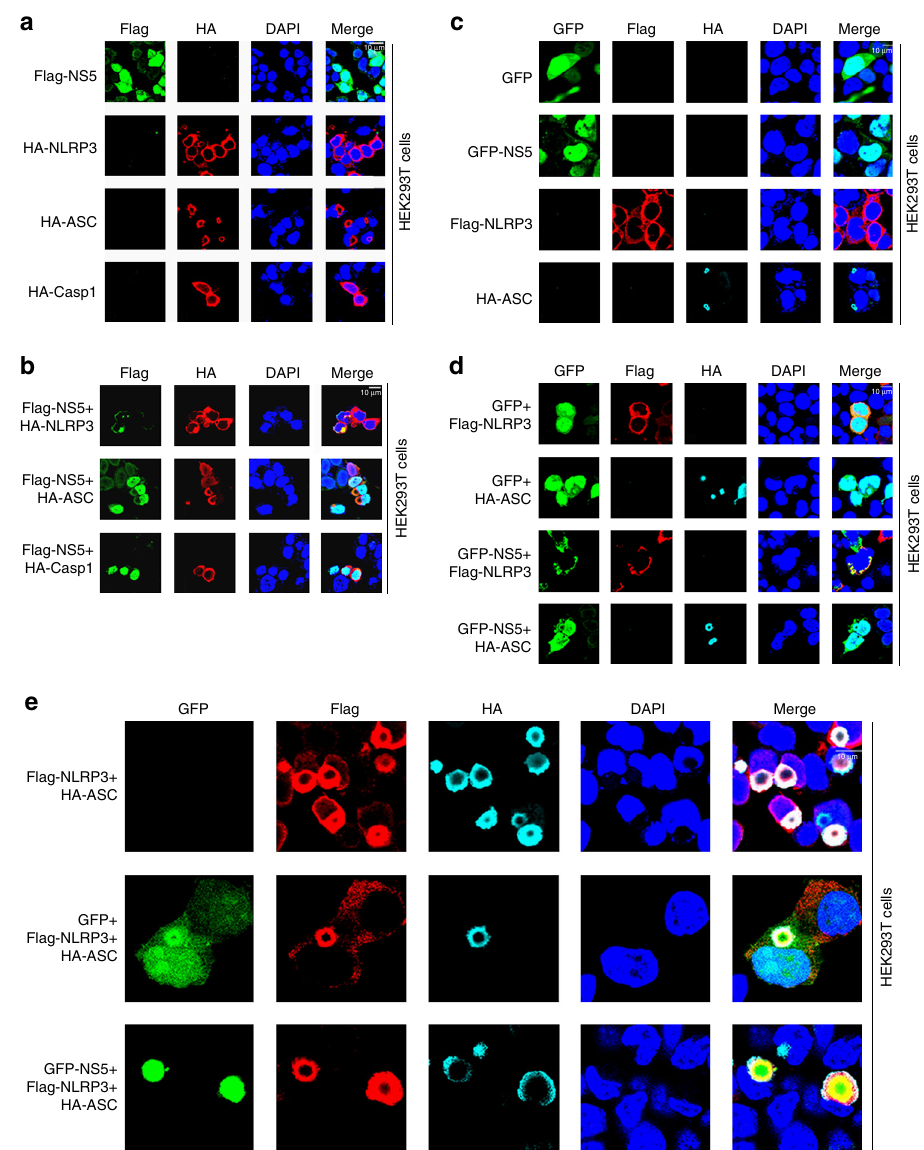
Fig. 6 Role of ZIKV NS5 in NLRP3 in fl ammasome assembly. a , b HEK293T cells were transfected with pFlag-NS5, pHA-NLRP3, pHA-ASC, or pHA-Casp-1 ( a ) or co-transfected with pFlag-NS5 and pHA-NLRP3, pHA-ASC, or pHA-Casp-1 ( b ). Subcellular localizations of Flag-NS5 (green), HA-protein (red), and the nucleus marker DAPI (blue) were examined by confocal microscopy. c – e HEK293T cells were transfected with pGFP, pGFP-NS5, pFlag-NLRP3, or pHA- ASC ( c ); co-transfected with pGFP+pFlag-NLRP3, pGFP+pHA-ASC, pGFP-NS5+pHA-NLRP3, or pGFP-NS5+pHA-ASC ( d ); or co-transfected with pFlag- NLRP3+pHA-ASC, pGFP+pFlag-NLRP3+pHA-ASC, or pGFP-NS5+pFlag-NLRP3+pHA-ASC ( e ). Subcellular localizations of Flag-NS5 (green), HA-protein (red), and the nucleus marker DAPI (blue) were examined by confocal microscopy. Scale bar is 10 μ